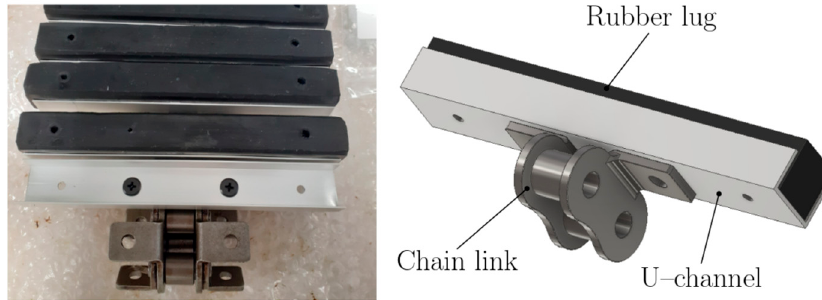
Figure 3. Track module.